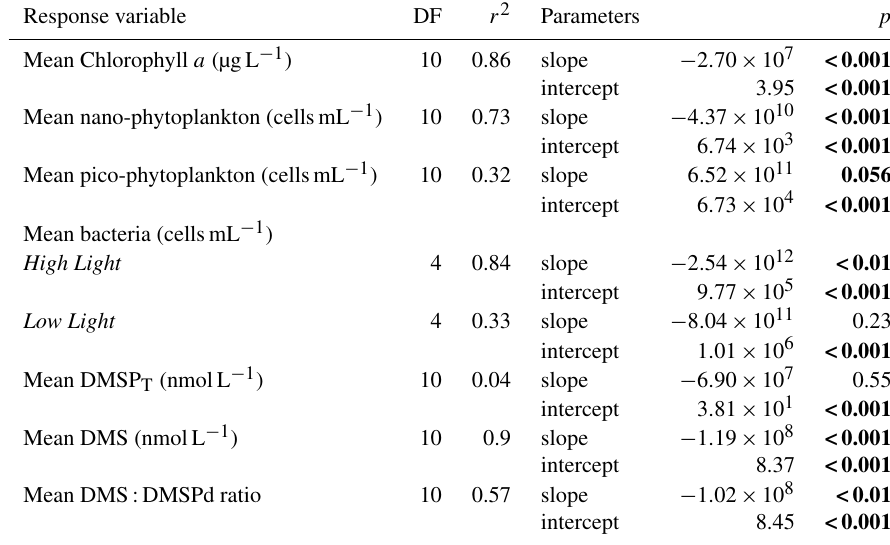
Table 4. Empirical relationships of various biological or chemical (response) variables with proton concentration (molL − 1 ) . Values are the means of all the microcosms. Linear regressions were performed on both light treatments when light had a significant effect on the response variable (see Table 3). Significant results are in bold, DF is the degrees of freedom, r 2 is the squared Pearson correlation coefficient between proton concentration and the response variable, and p is the significance of each parameters of the